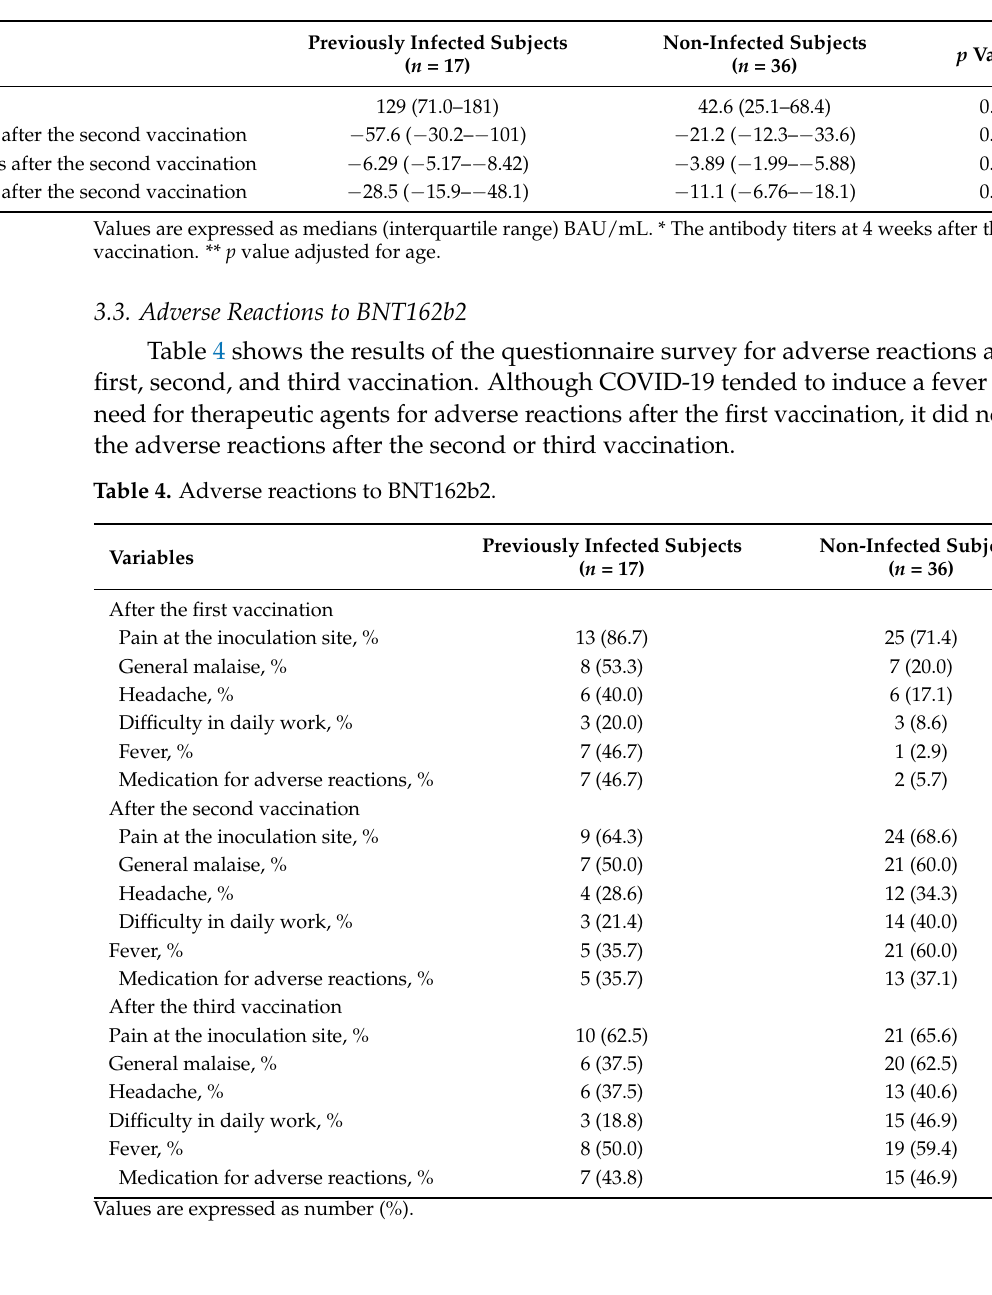
Table 3. Changes in titers per day before and after the peak of the antibody titers.